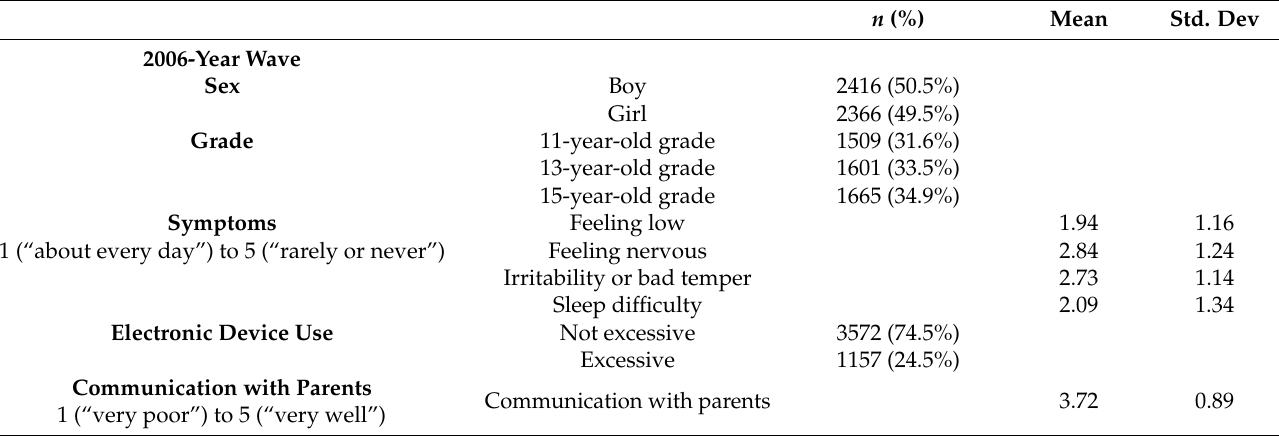
Table 1. Descriptive statistics depicting the sample characteristics in two